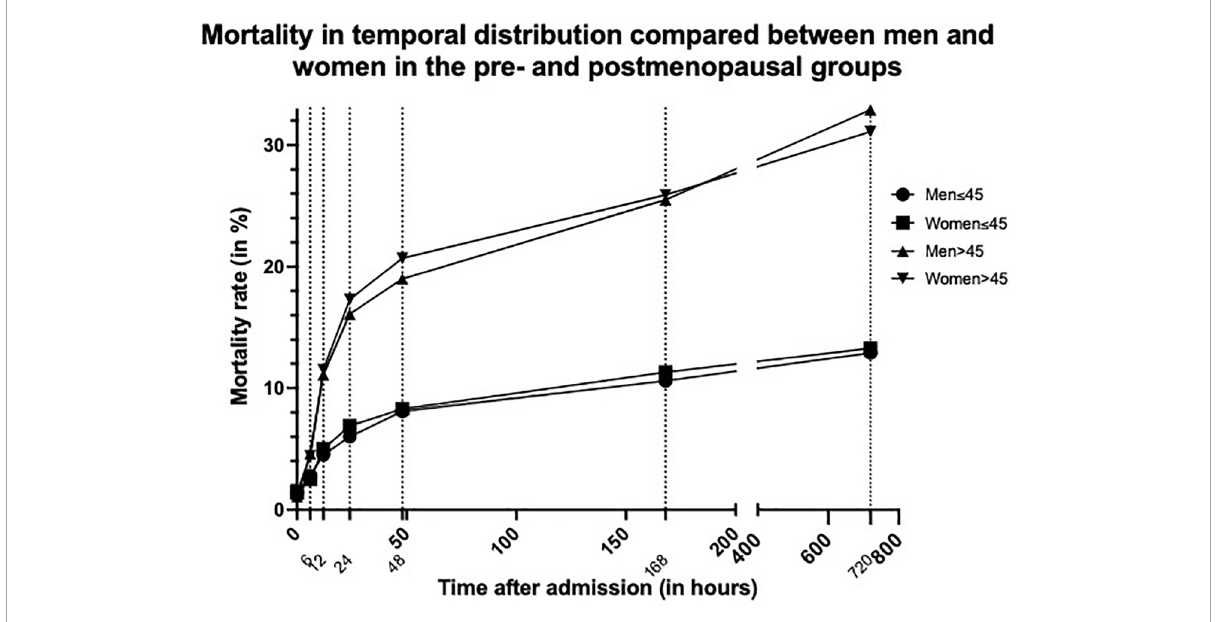
FIGURE2 Graph showing mortality rate in temporal distribution compared between men and women in the pre ( ≤ 45 years)- and postmenopausal ( > 45 years) groups. Dotted lines indicate the different measurement times.